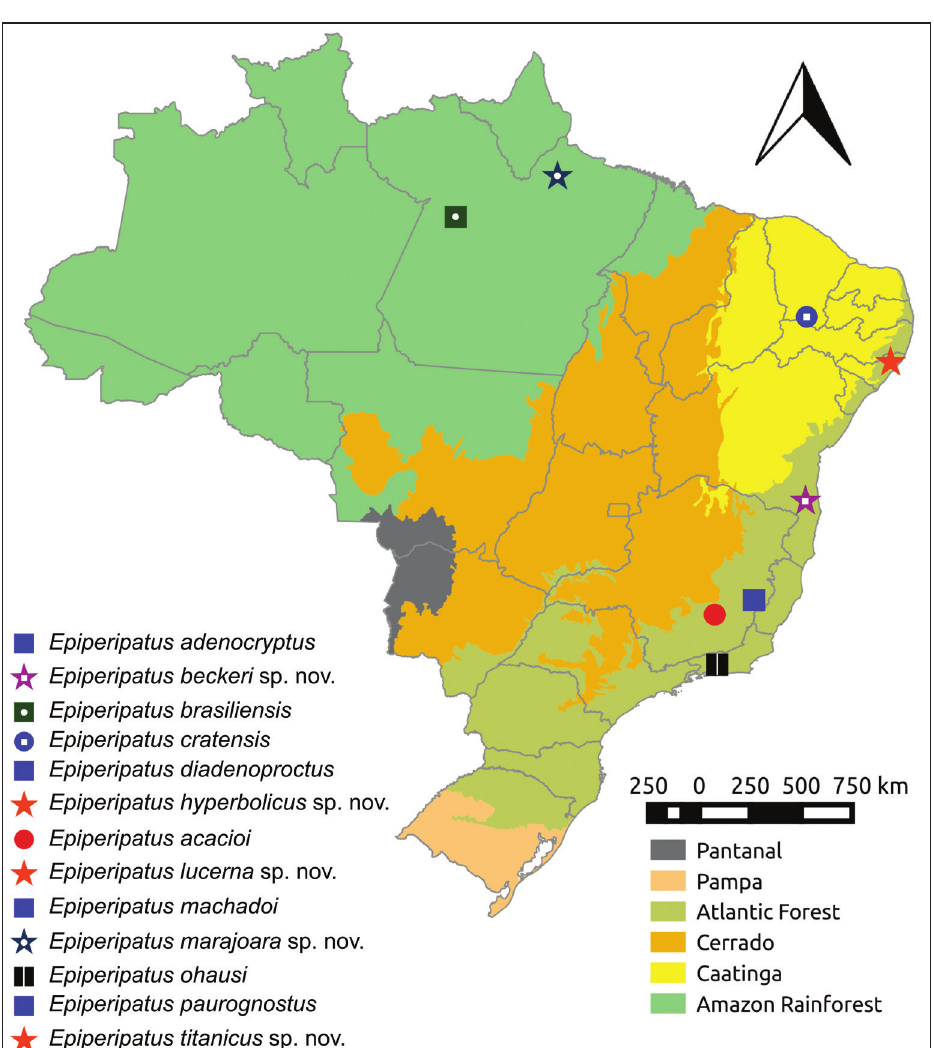
Figure 37. Distribution records of species of Epiperipatus in Brazil. Colors on the map correspond to biomes. The new species are represented by stars on the map. The absence of E. tucupi , is due to the inaccurate original label (the only data is “Pará state”).